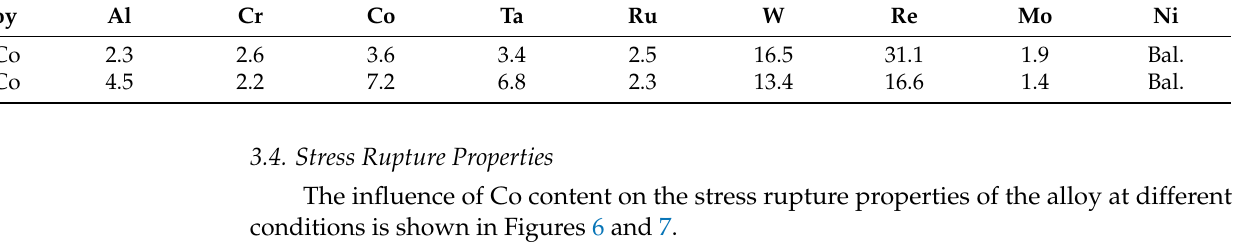
( a ) ( b ) Figure 7. Influence of Co content on the stress rupture properties of the alloy at 1140 °C/137 Mpa: ( a ) stress rupture life and ( b ) elongation. Figures 6 and 7 illustrate that with increasing Co content, the stress rupture life of the alloy at 1100 °C/137 MPa and 1140 °C/137 MPa all reduce in different degrees; the elonga- tion at 1100 °C/137 MPa increases at first and decreases afterwards, but then at 1140 °C/137 MPa, monotonously increases. When Co content increases from 6% to 9% and 12%, the stress rupture life at 1100 °C/137 MPa decreases by 4.5% and 42.2%, then at 1140 °C/137 MPa and declines by 16.7% and 76.9%, respectively. This indicates that the effect of the Co element on the stress rupture life of the alloy improves with the increase in Co content or test temperature. 3.5. Microstructure of Stress Ruptured Samples The longitudinal section microstructure of the stress ruptured samples with different Co content at 1100 °C/137 MPa and 1140 °C/137 MPa was observed. Figures 8 and 9 show the microstructure at 1.5 cm from the fracture surface of the ruptured samples at different conditions, while Figures 10 and 11 show the microstructure adjacent to the fracture sur- face of the ruptured samples at different conditions. It is shown in Figure 8 that the γ ′ particles degenerate into the rafts in the orientation vertical to the tensile stress for three alloys at the condition of 1100 °C/137 MPa. The dif- ference is that the thickness of the raft decreases slightly with the increase in Co content in addition to the presence of the TCP phase in the 6% Co alloy. The continuity of the rafted structure is destroyed by the acicular TCP phase. It can be seen in Figure 10 that the γ matrix is not continuous and has become islands that are completely surrounded by the γ ′ precipitates, which is called “topological inversion” [16]. The raft displays a slightly twisted configuration because the stress state near the fracture surface is different to that